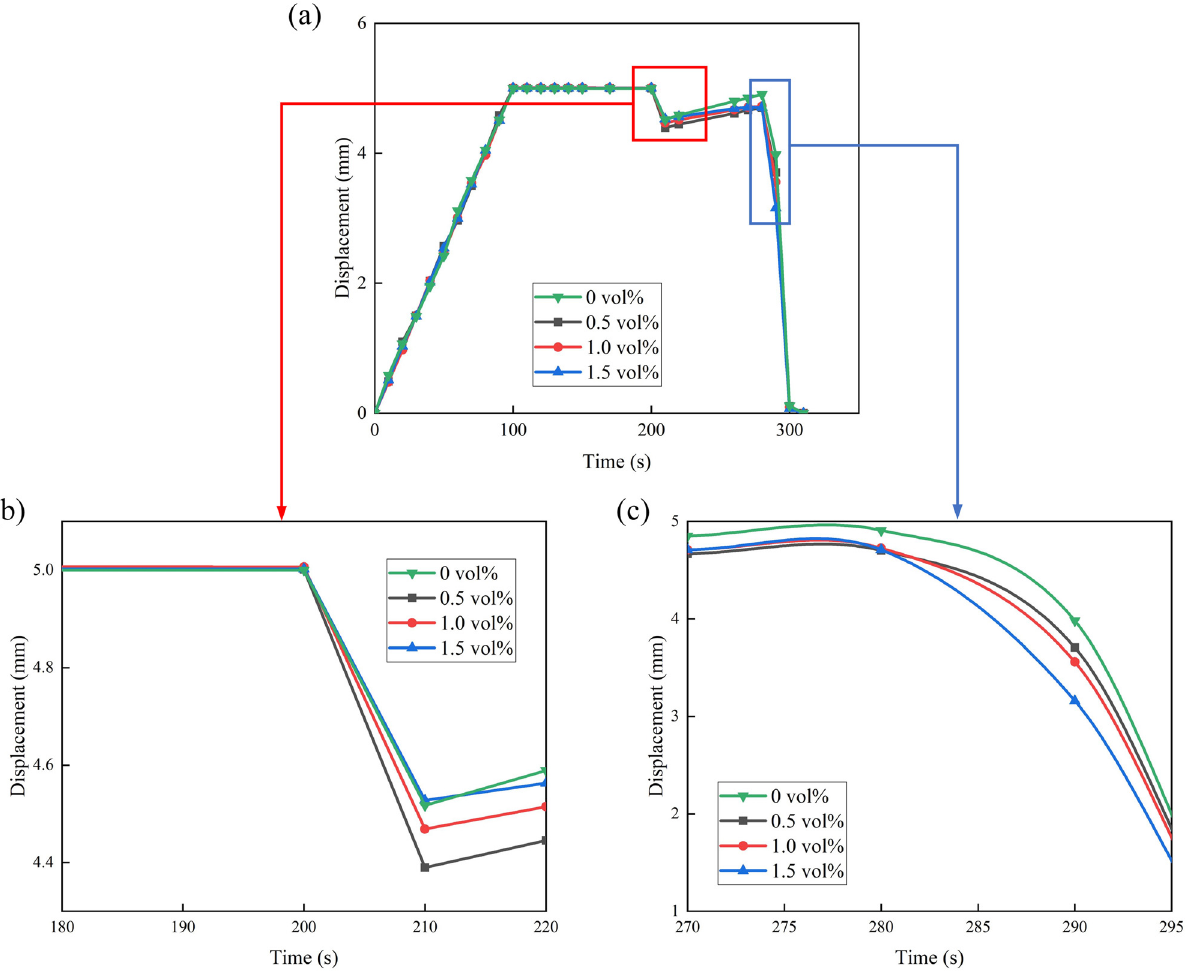
Figure 10: Displacement - time relationship: ( a ) 0 – 300 s, ( b ) 180 – 220 s, and ( c ) 270 – 295